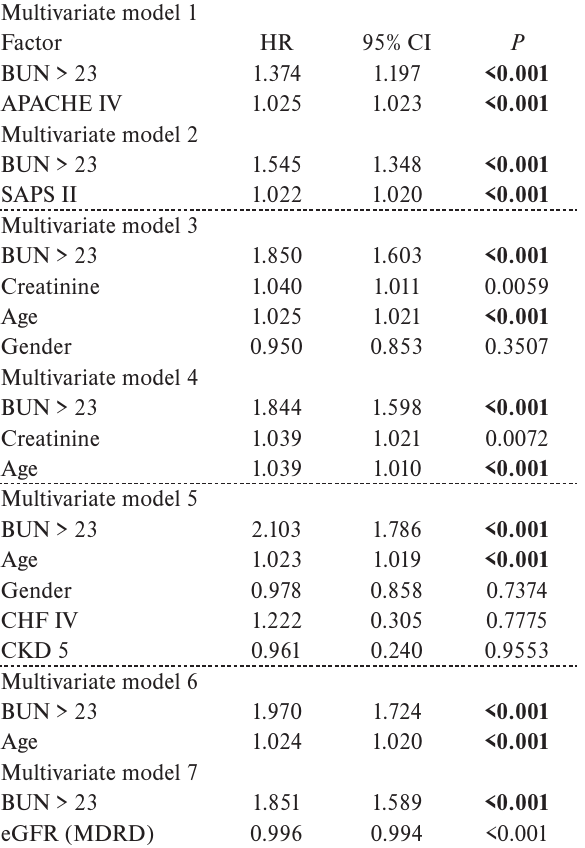
Table 7. Multivariate Analysis eICU